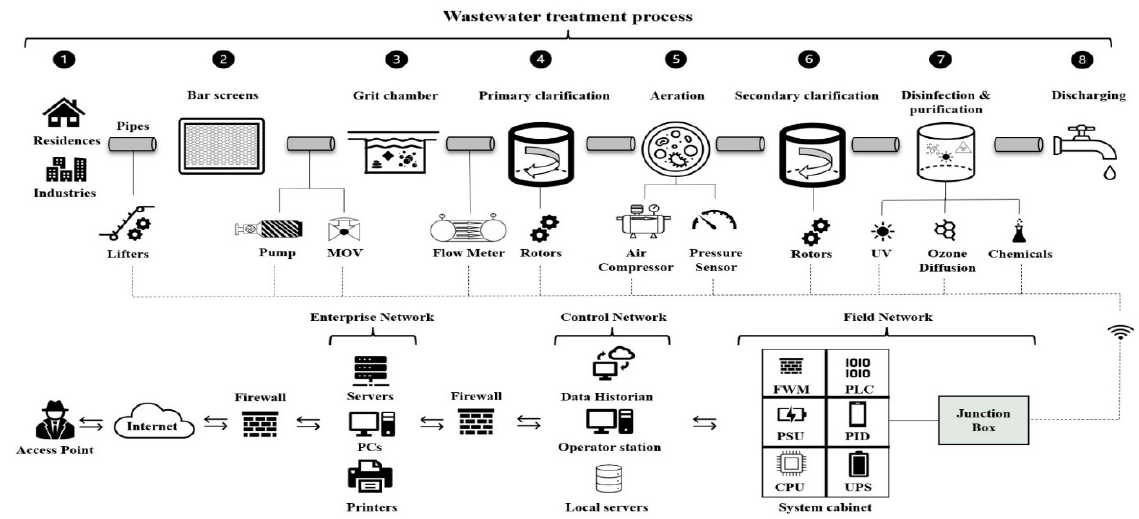
Figure 1. System Architecture for Wastewater Treatment Plant (WTP).